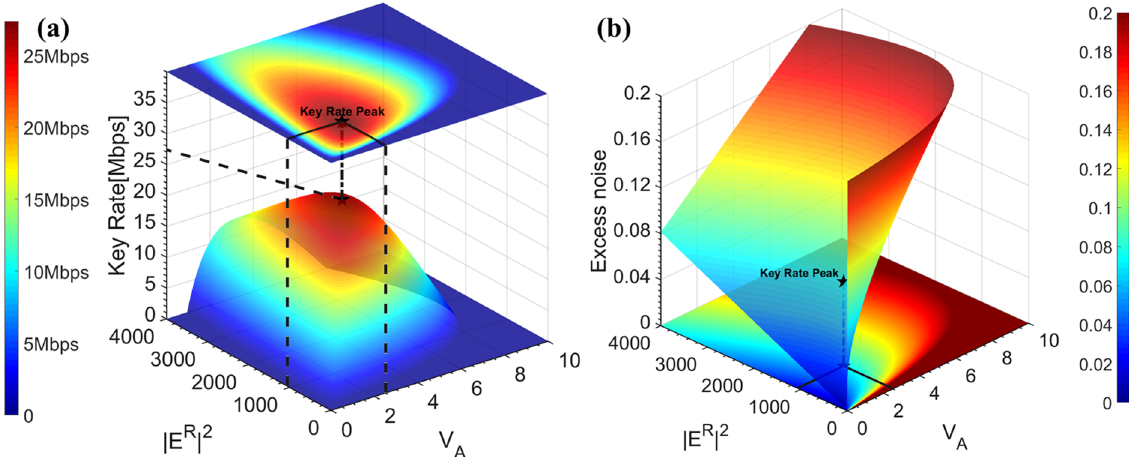
Figure 2. The demonstration of the proposed combined-optimization method with respect to different V A = [0 10] and E 2 Ref = [0 4000] at L = 15 km and f ref =500 MHz. All other parameters used in the estimations are listed in Methods section. ( a ) The secure key rate analysis for various V A and the simulation is 27.3 Mbps obtained when V A =2.52 and